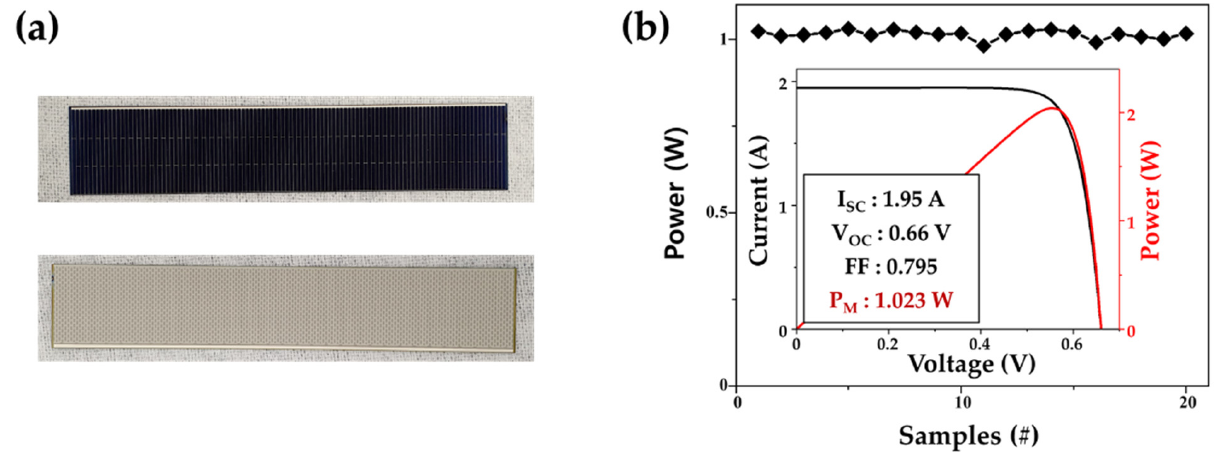
Figure 3. ( a ) Photo images of the front and rear sides of the separated cells and ( b ) the conversion power distribution of 20 separated cells. Inset: I-V curve of a champion cell.